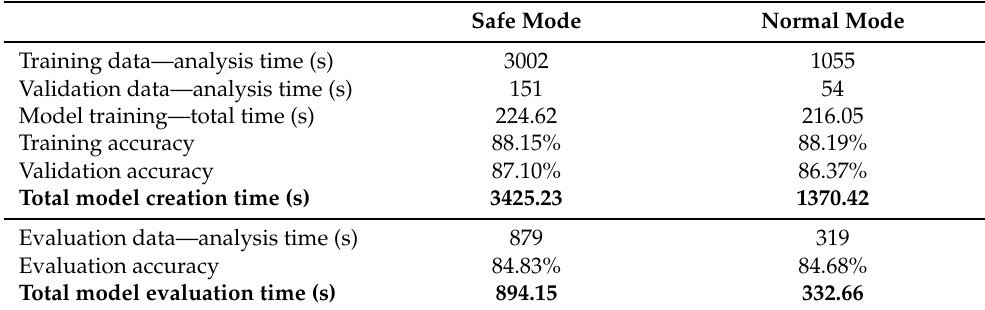
Table 2. Comparison of the averaged measurement results of the ‘Animals’ dataset for the safe and normal boot